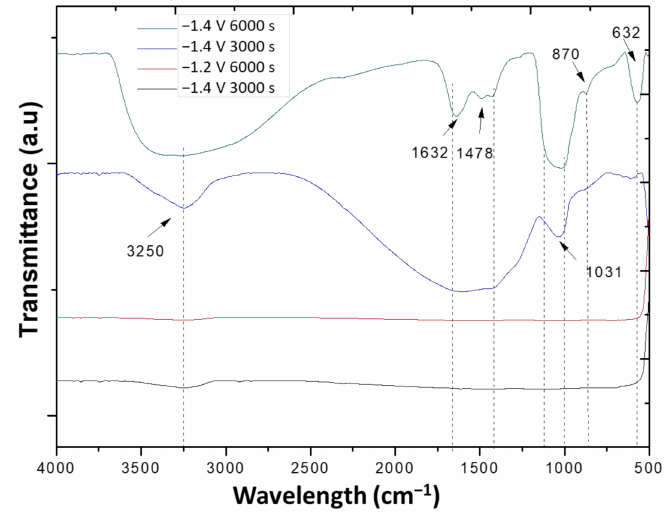
Figure 7. FTIR spectra electrodeposited layer on etched SS at different potentials and time.